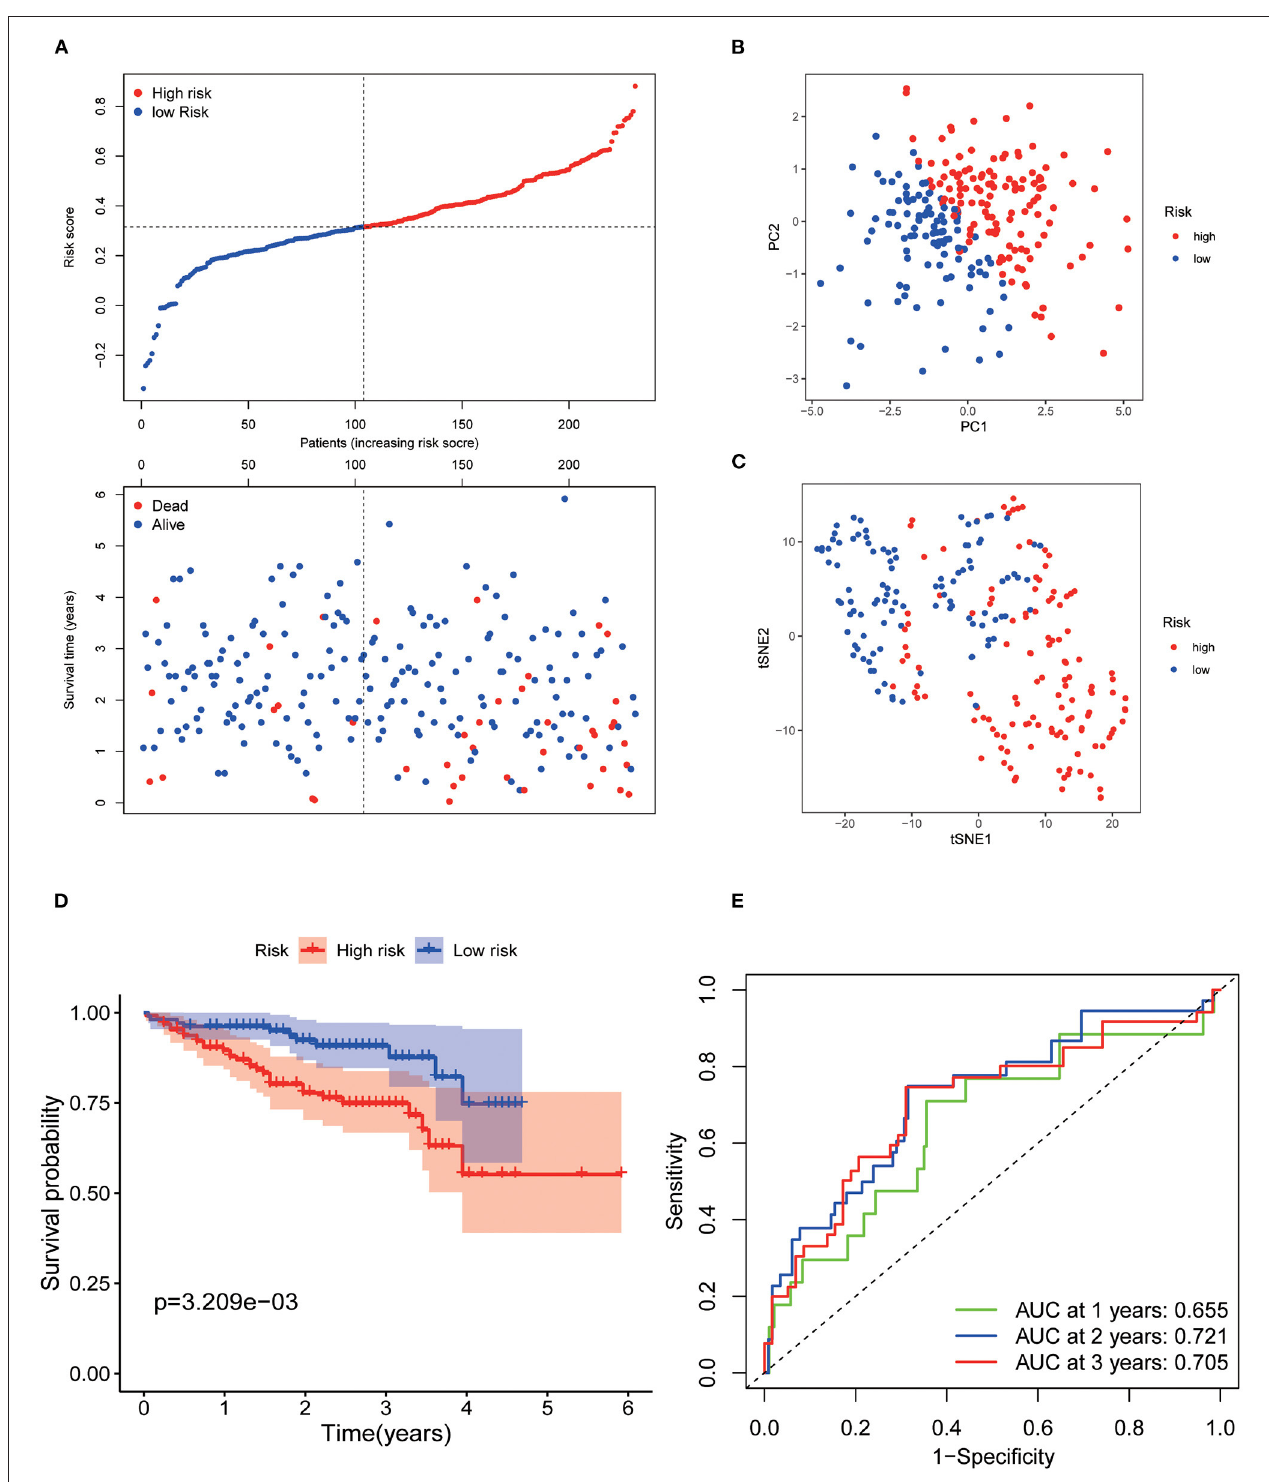
FIGURE 3 | Validation of the 7 AGs signature model in the ICGC cohort. (A) Risk plot distribution and survival status. (B) PCA plot of the risk score. (C) t-SNE analysis of the risk score. (D) Kaplan–Meier curves for the OS. (E) AUC of time-dependent ROC curve of the risk score.